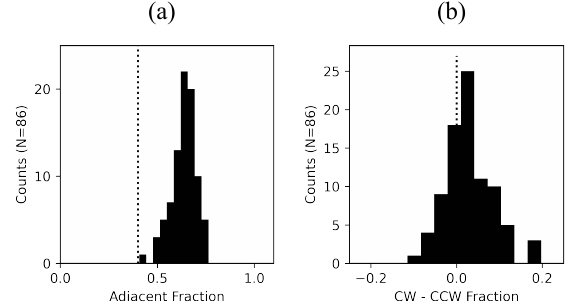
Figure 4. Sequential gaze patterns. (a) Fraction of adjacent letters viewed; (b) Difference in a fraction of clockwise (CW) versus counter-clockwise (CCW) gaze